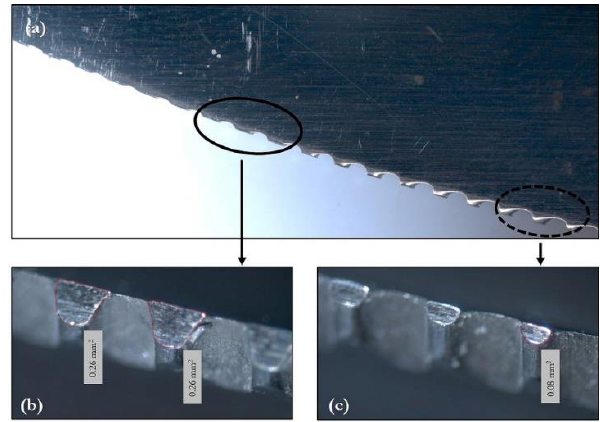
Figure 10. Knife wear ( a ) observed with naked eye; ( b ) heavy wear and ( c ) initial wear observed with optic microscope .